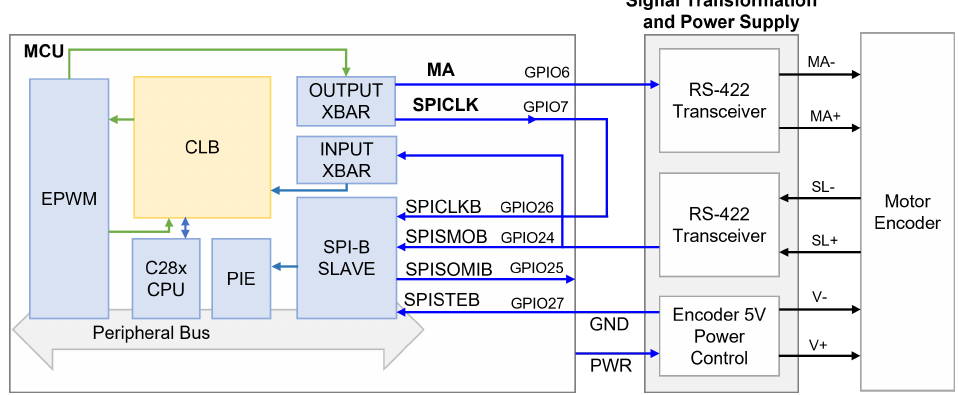
Figure 6. Hardware structure of BiSS-C